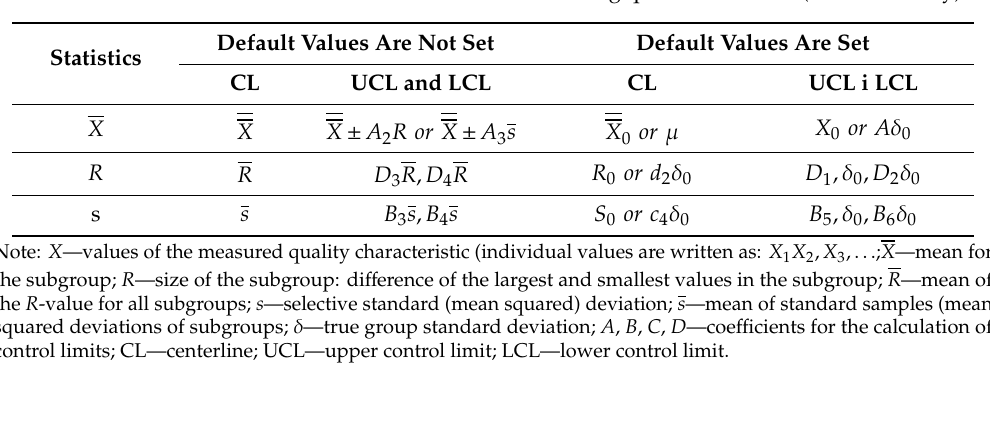
Table 1. Formulas of control limits for Shewhart charts using quantitative data (author’s